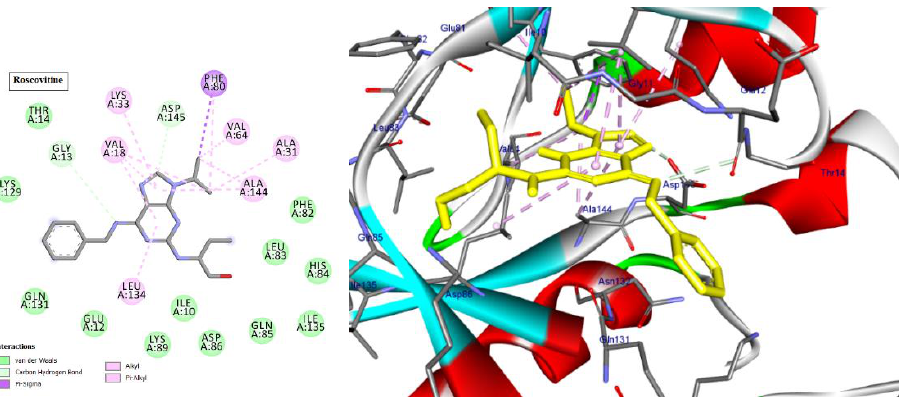
Figure 5. Two-dimensional and three-dimensional images of cocrystal ligand (Roscovitine) docked into the ATP binding site CDK-2 enzyme.